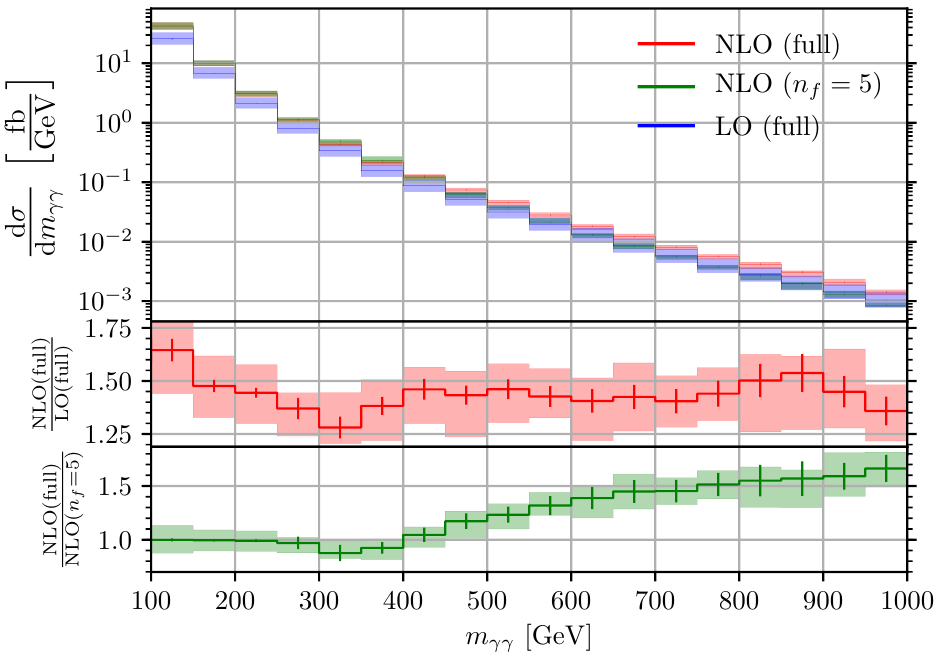
Figure 3. Diphoton invariant mass distribution ((cid:12)xed order calculation), comparing the result with n f = 5 to the result including massive top quark loops. The lower panels show the ratios NLO(full) = LO(full) and NLO(full) = NLO( n f = 5). The shaded bands show the envelope of the 7-point scale variation as explained in the text. In the ratio plots, only the scale of the numerators is varied, while the scale of the denominators is (cid:12)xed to (cid:22) R = (cid:22) F = m (cid:13)(cid:13) = 2. The bars indicate the uncertainty due to the numerical evaluation of the phase-space and loop